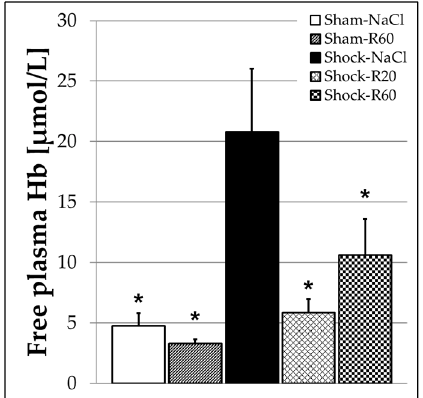
Figure 7. Effect of continuous intravenous infusions of solvent-free low-dose resveratrol on the free plasma hemoglobin concentration (hemolysis) subsequent to severe hemorrhagic shock in rats. Rats underwent severe hemorrhage (30 min shock induction, 60 min shock phase), then were resuscitated within 30 min with the withdrawn blood and lactated Ringer’s equal to twice the volume of the withdrawn blood in the absence (Shock-NaCl) or presence of resveratrol (20 or 60 μ g/kg × h until the end of the experiment; Shock-R20, Shock-R60) and observed for a further 150 min. Sham animals received either pure 0.9% NaCl solution (Sham-NaCl) or the higher resveratrol dose (Sham-R60). The free hemoglobin (Hb) concentration was determined in plasma from final blood samples as obtained immediately before rats were sacrificed. Shown are mean values ± SEM ( n = 8 animals per group). * p < 0.05 (vs. Shock-NaCl).